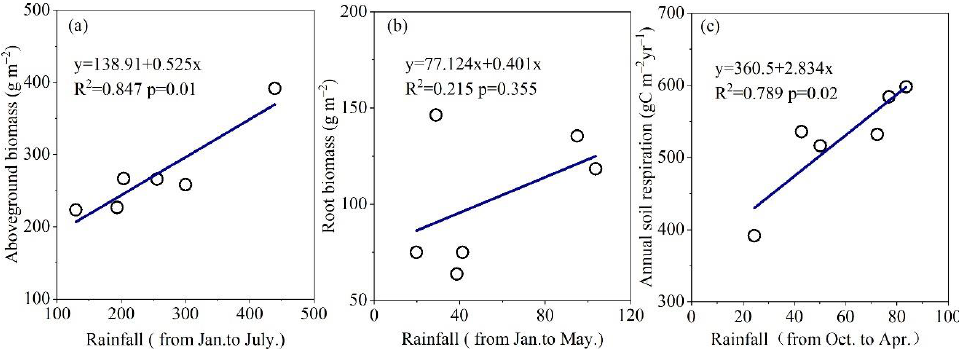
Figure 7. Relationships of precipitation measures of different monthly durations with aboveground biomass ( a ), root biomass ( b ), and annual soil respiration ( c ).